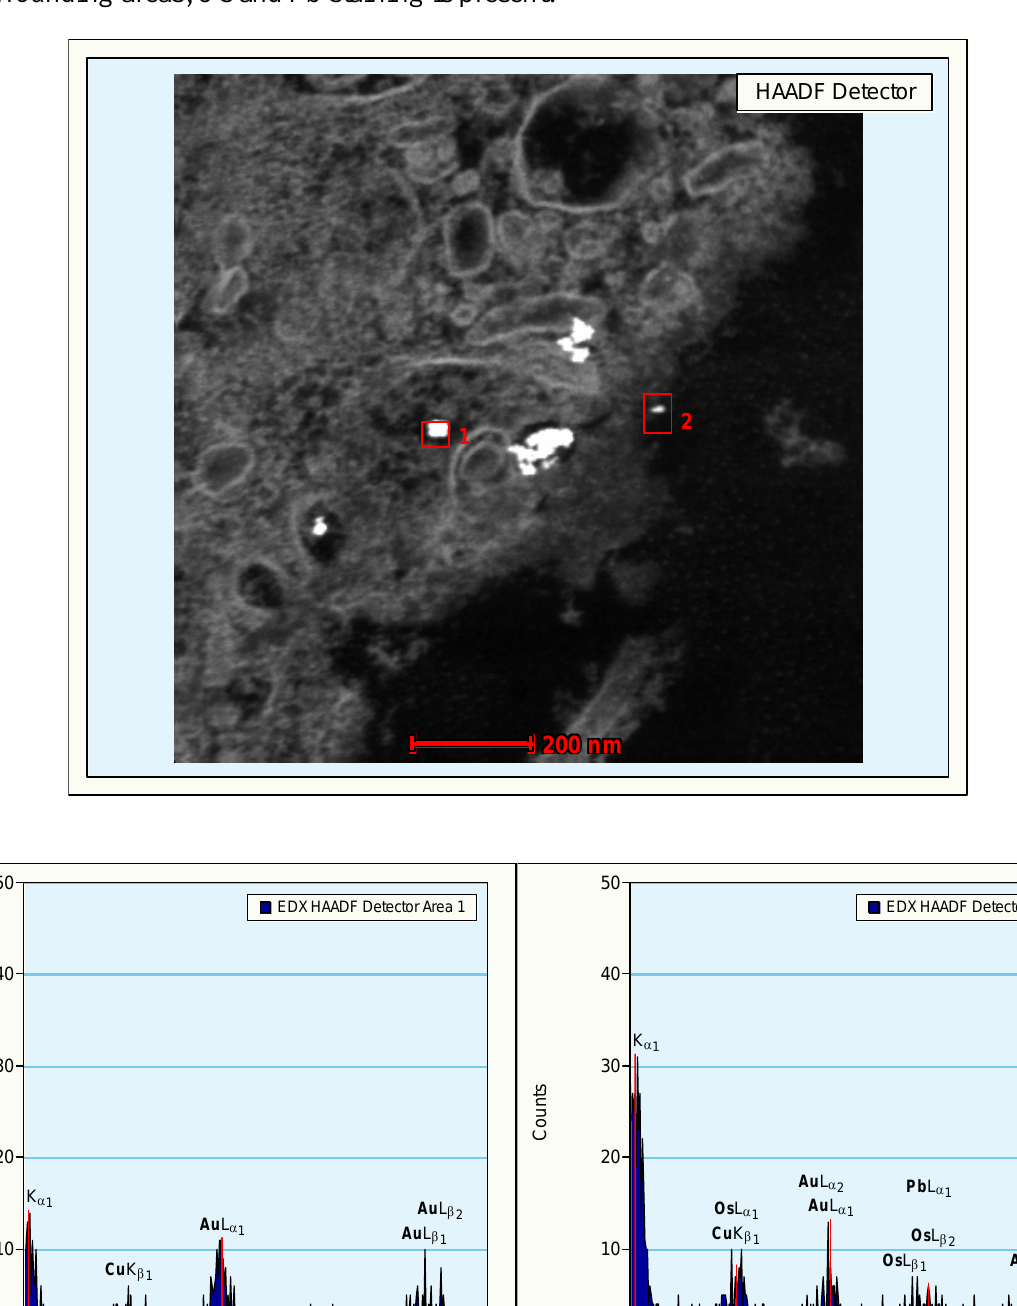
Figure 8 . Presence of gold nanoparticles in Kupffer cells of the liver. Marker indicates 200 nm (top panel). Positive identification of the element gold in the observed nanostructures by EDX analysis. Area 1: a larger cluster of Au particles (10 nm; bottom left panel). Area 2: an area containing 2 Au particles (bottom right panel). In the surrounding areas, Os and Pb staining is